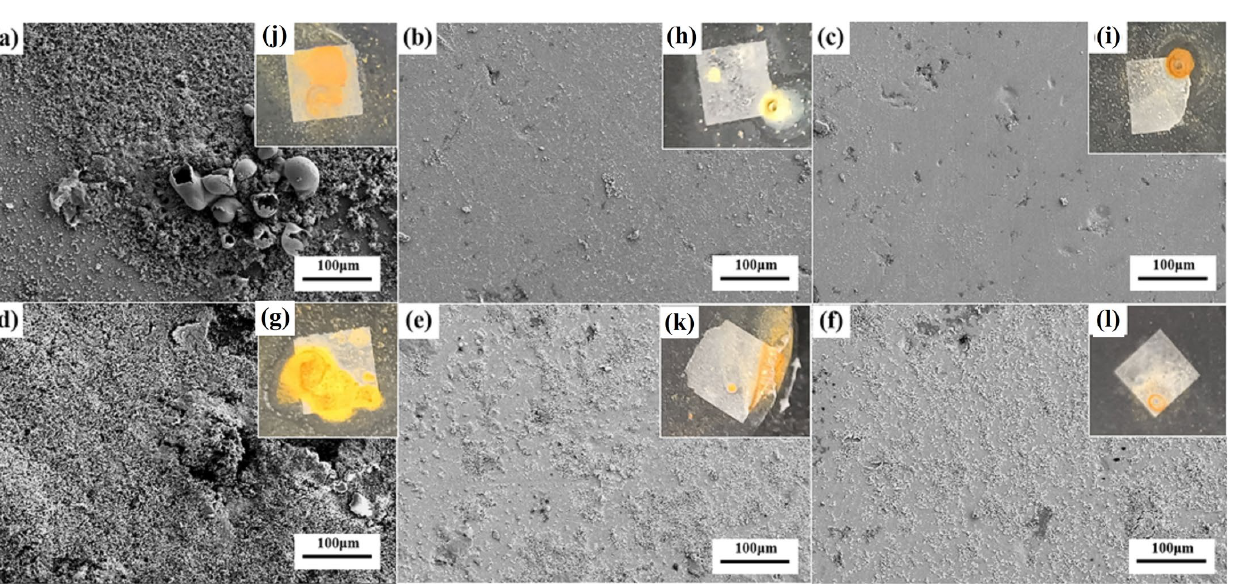
Figure 10. Morphologies of coatings immersed for 1 ( a – c , g – i ) and 7 ( d – f , h , j , l ) days: (a,d,g,j) Fe-based coating, (b,e,h,k) 6% γ -Fe coating, and (c,f,i,l) 9% γ -Fe coating.